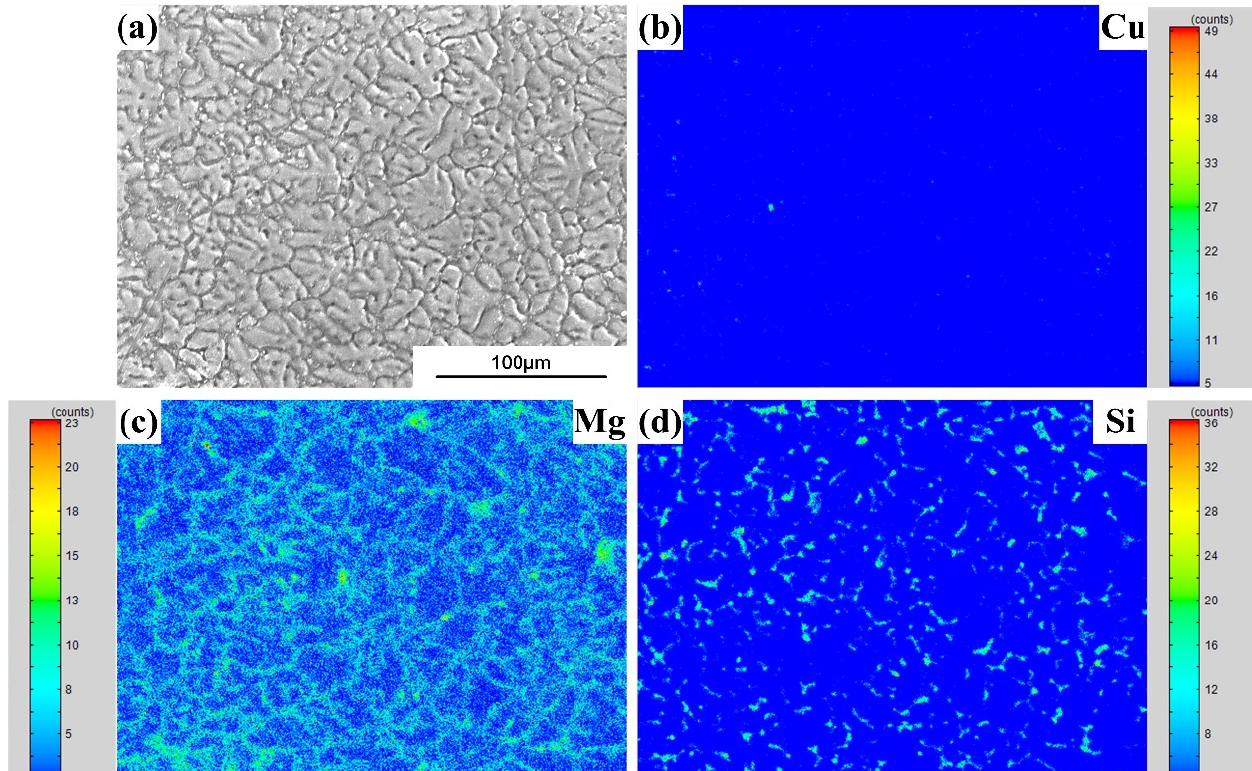
Figure 9. The EPMA mapping results (the AA7075/Al-Cu 1.5 -Si 4.5 weld): ( a ) Secondary electronic image; ( b ) Cu distribution; ( c ) Mg distribution; ( d ) Si distribution.